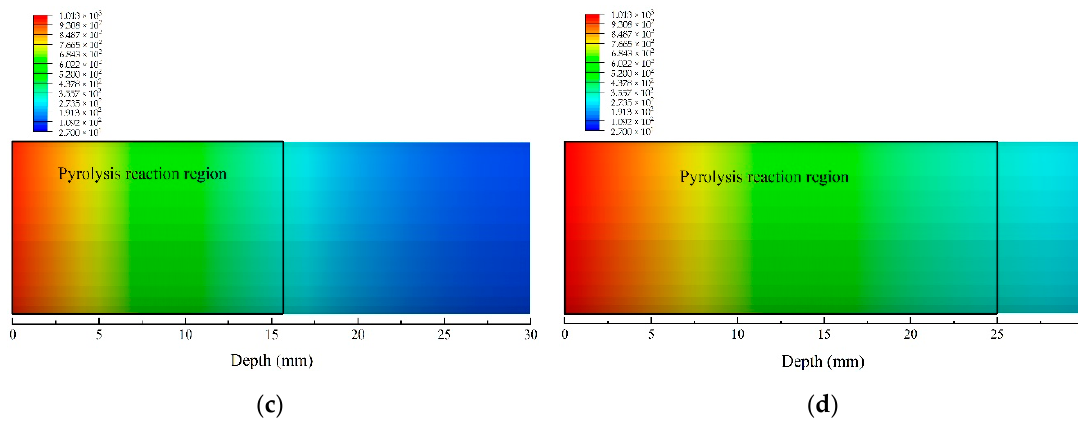
Figure 6. Temperature contours of the glass fiber/phenolic resin composites at different times under one sided heating. ( a ) 50 s; ( b ) 200 s; ( c ) 400 s; ( d ) 800 s.